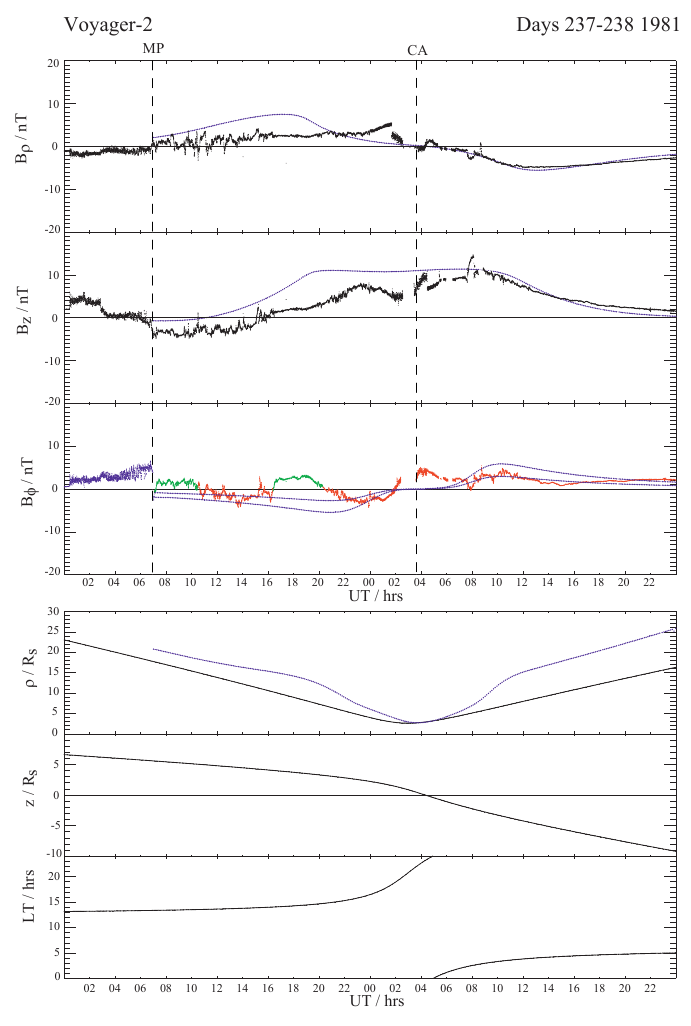
Fig. 6. As for Fig. 5, except for the Voyager-2 flyby. In this case the data correspond to days 237 and 238 of 1981. The left-hand vertical dashed line shows the single inbound magnetopause crossing at 19 R S , while the central vertical dashed line shows closest approach at 2.7 R S